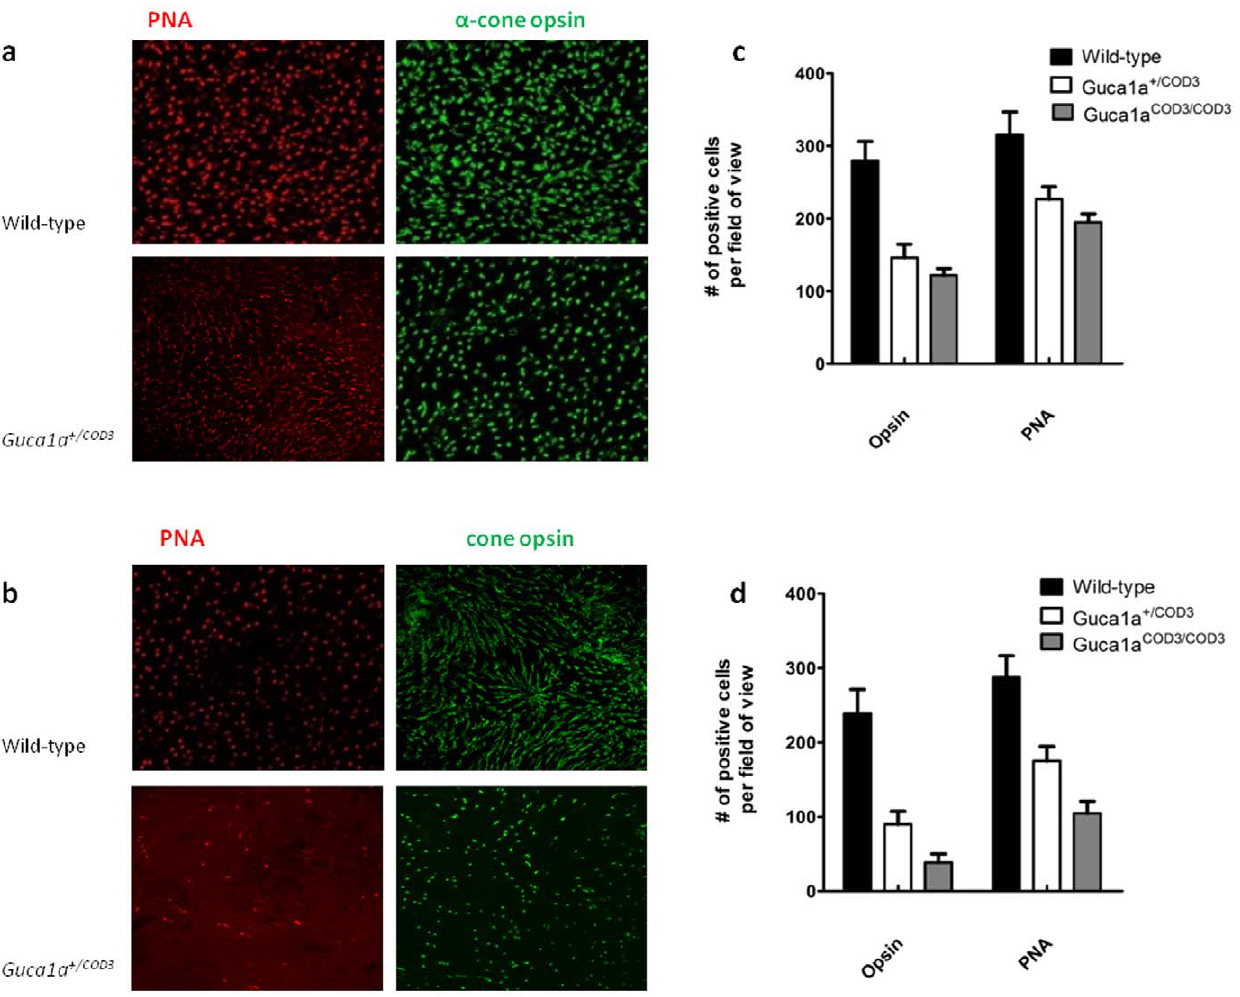
Figure 6. Mutant GCAP1 leads to progressive loss of cone photoreceptors. ( a ) Representative retinal flat mounts taken from 5 month-old mice stained with PNA and anti-cone opsin antibody. There are fewer PNA-positive cone cells present in mutant compared to wild-type retinae, as well as a fewer opsin-expressing cells in mutant versus wild-type retinae. Quantitative analysis shows that there are significantly fewer cone opsin- expressing cells in mutant retinae than PNA-positive cells, although the labelling of both markers is significantly reduced in Guca1a + /COD3 and Guca1a COD3/COD3 mice as compared to wild-type littermates. ( b ) Representative retinal flatmounts taken from 12 month-old mice confirms progression of cone degeneration; in mutant mice, there are fewer opsin-positive cells at 12 months compared to wild-type